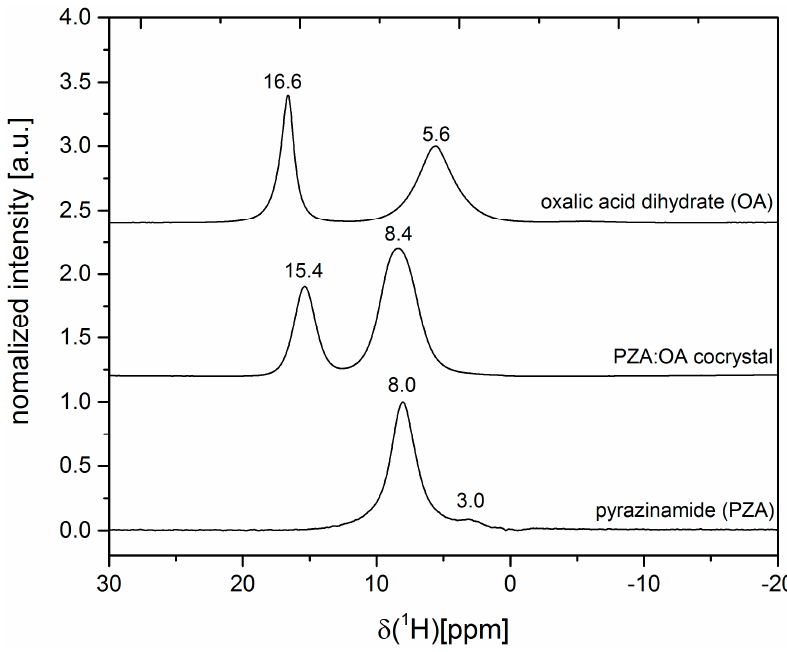
Figure 3. Solid-state NMR spectra of the PZA:OA (1:1) cocrystal ( center ) and the reactants pyrazinamide ( bottom ) and oxalic acid dihydrate ( top ).